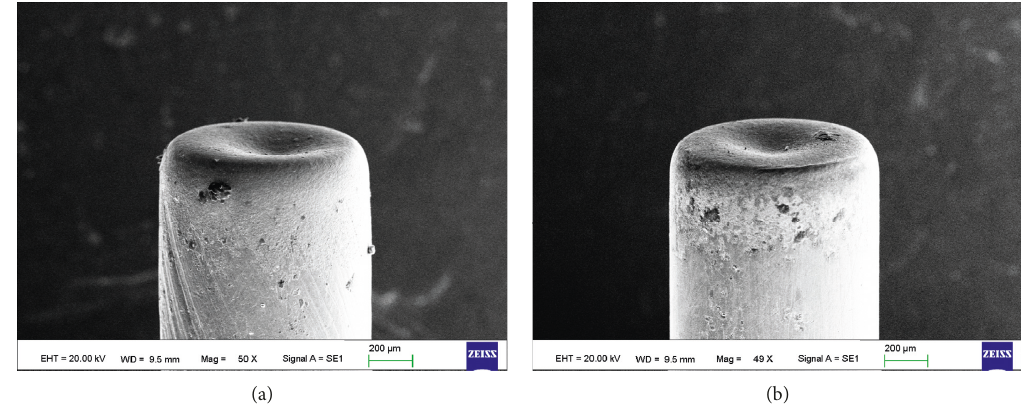
Figure 12: Changes in the electrode shape at the same pulse frequency (no. 5 in Table 1). (a) ON 1 μ s, OFF 2 μ s. (b) ON 2 μ s, OFF 1 μ s.